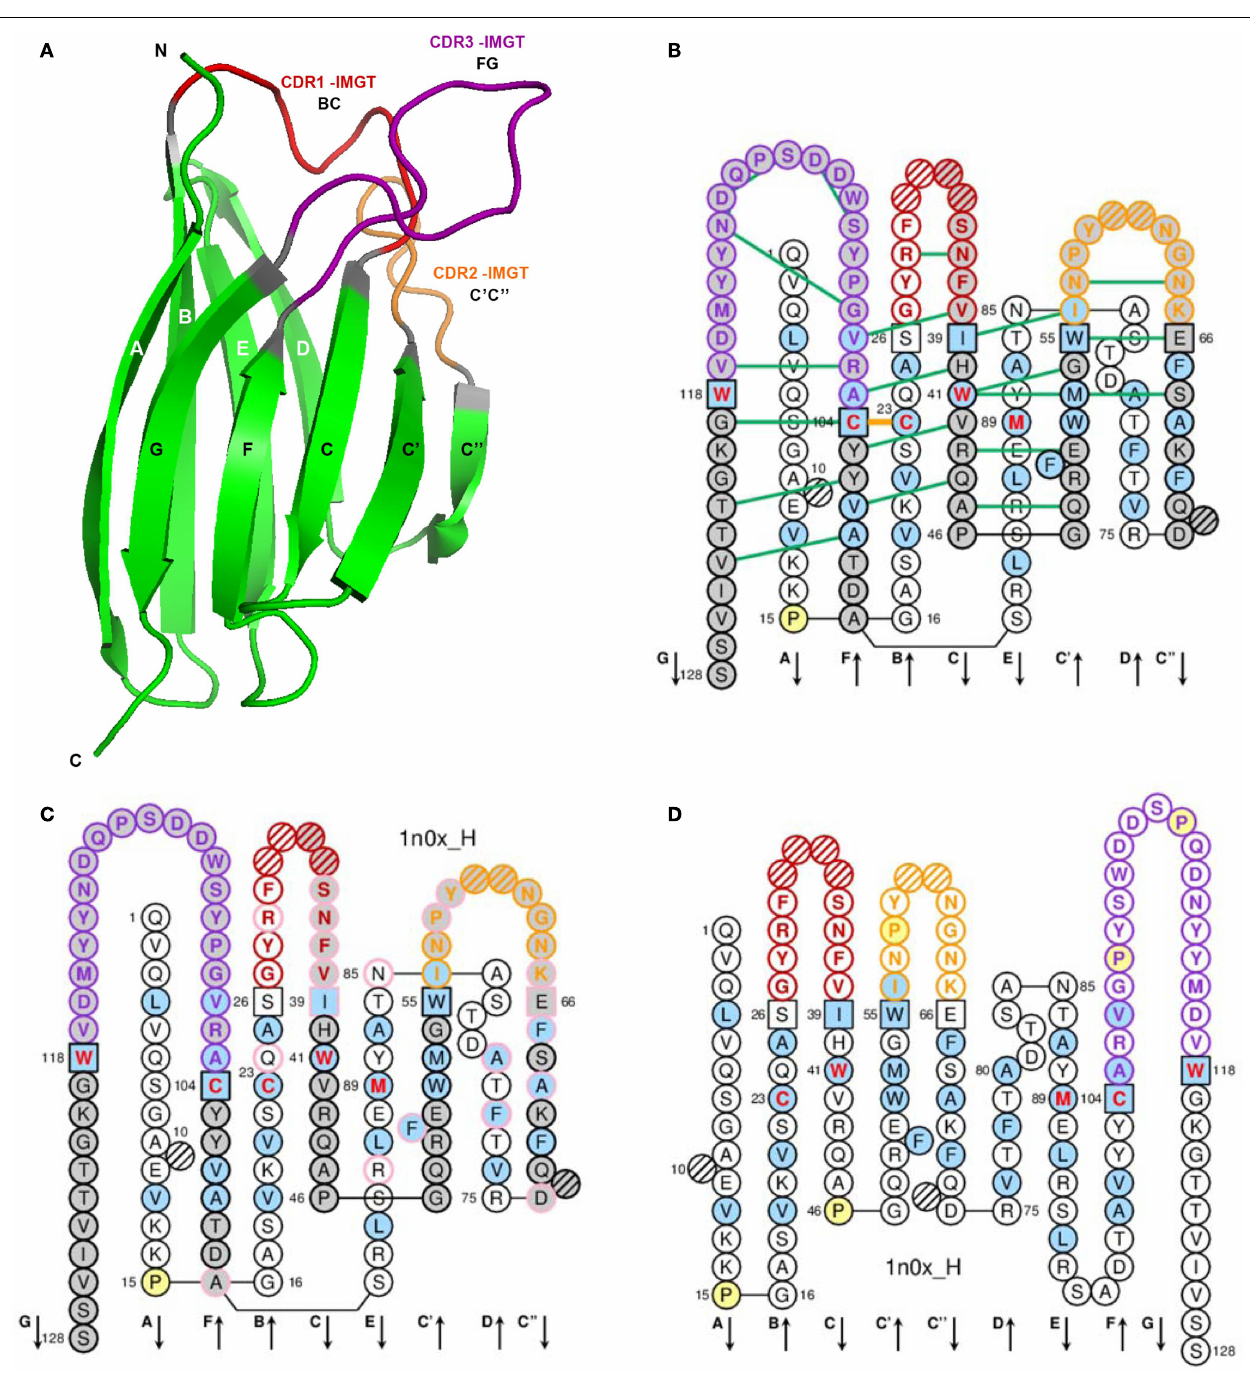
FIGURE 3 |Variable (V) domain . An IGVH (V-DOMAIN) is shown as an example. (A) 3D structure ribbon representation with the IMGT strand and loop delimitations (64). (B) IMGT Collier de Perles on two layers with hydrogen bonds.The IMGT Collier de Perles on two layers show, in the forefront, the GFCC’C” strands (forming the sheet located at the interface VH/VL of the IG) and, in the back, the ABED strands.The IMGT Collier de Perles with hydrogen bonds (green lines online, only shown here for the GFCC (cid:48) C (cid:48)(cid:48) sheet) is generated by the IMGT/Collier-de-Perles tool integrated in IMGT/3Dstructure-DB, from experimental 3D structure data (11–13). (C) IMGT Collier de Perles on two layers generated from IMGT/DomainGapAlign (12,